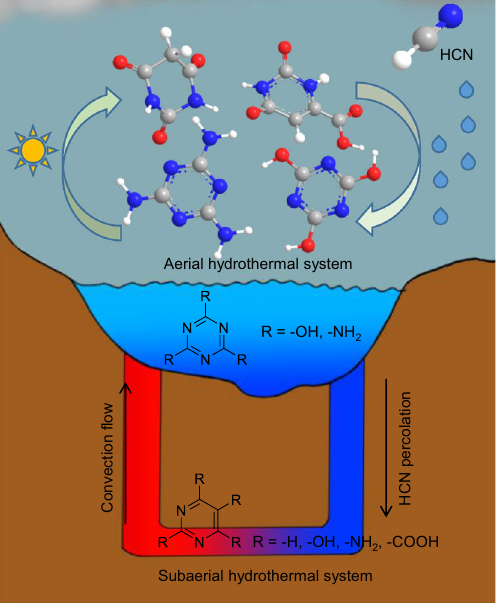
Figure 2. Plausible geological scenario for the synthesis of pyrimidines and triazines, showing aerial and subaerial alkaline hydrothermal conditions and the possible flow of HCN and organic compounds around the cycle. In this scenario, the atmospheric HCN, which can be produced through several pathways 27–30,32,37,38 , would rain fall over an alkaline aerial hydrothermal system. In this way, the dissolved atmospheric HCN would be concentrated tough wet-dry cycles and then driving the subsequent aqueous reactions to the preferential generation of triazines. Moreover, the concentrated cyanide might be percolated to the subaerial part of the hydrothermal system, leading to the preferential synthesis of pyrimidines. Again, thanks to the convection flow the pyrimidines would be in touch with triazines in the upper part of the hydrothermal system and the wet-dry cycles might favour the production of supramolecular assemblies such as melamine ( 11 ):cyanuric acid ( 14 ) and barbituric acid ( 8 ): melamine ( 11 ). Experimentally to simulate this plausible alkaline scenario, NH 4 Cl has been used to adjust the pH. This soluble salt could be formed and concentrated in analogous way to the HCN. Atmospheric NH 3 is dissolved in the aqueous environment and concentrated by evaporation as NH 4 Cl, due to the general presence of chloride salts in the geochemical aqueous pools 39